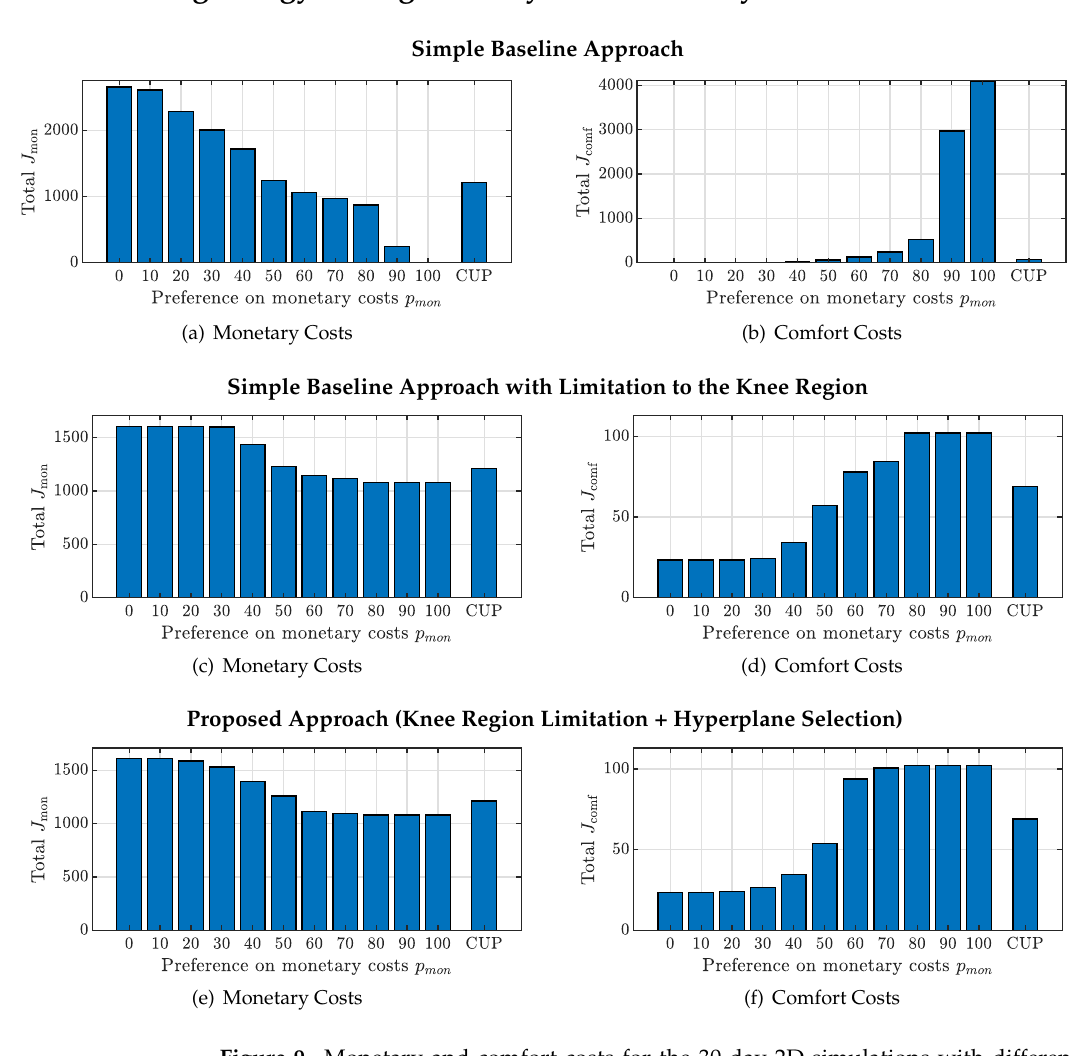
Figure 9. Monetary and comfort costs for the 30-day 2D simulations with different preferences p mon and p comf for ( a , b ) the simple baseline approach, ( c , d ) the simple baseline approach but with limitation to the knee region, and ( e , f ) the proposed preference-based decision making approach, with r lim = 0.85 for the latter two cases. Results from using the closest to Utopia point (CUP) metric are plotted for